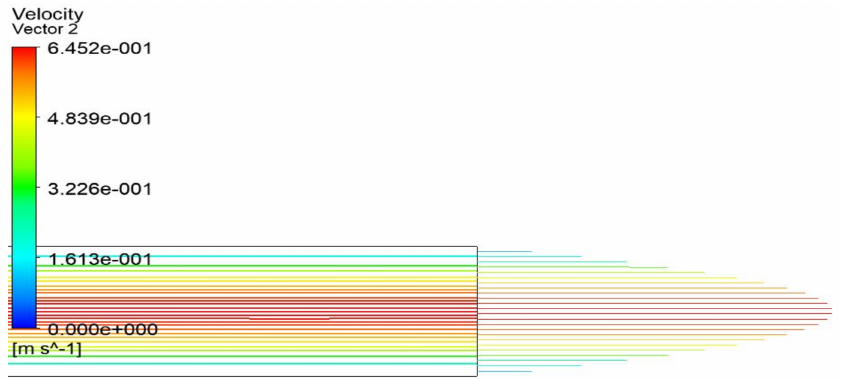
Figure 9. Two-dimensional pictorial view of the fully developed flow in between the